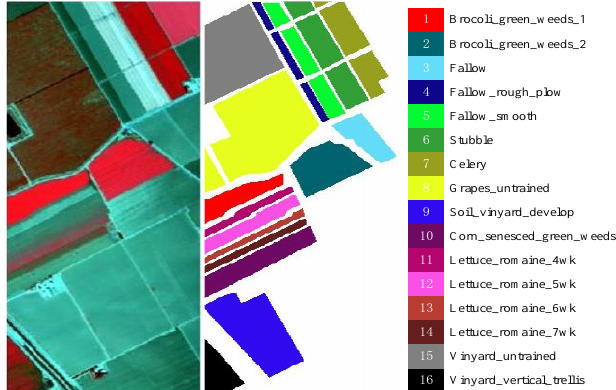
Figure 7. Ground truth map, pseudocolor images, and available samples of Salinas scene.